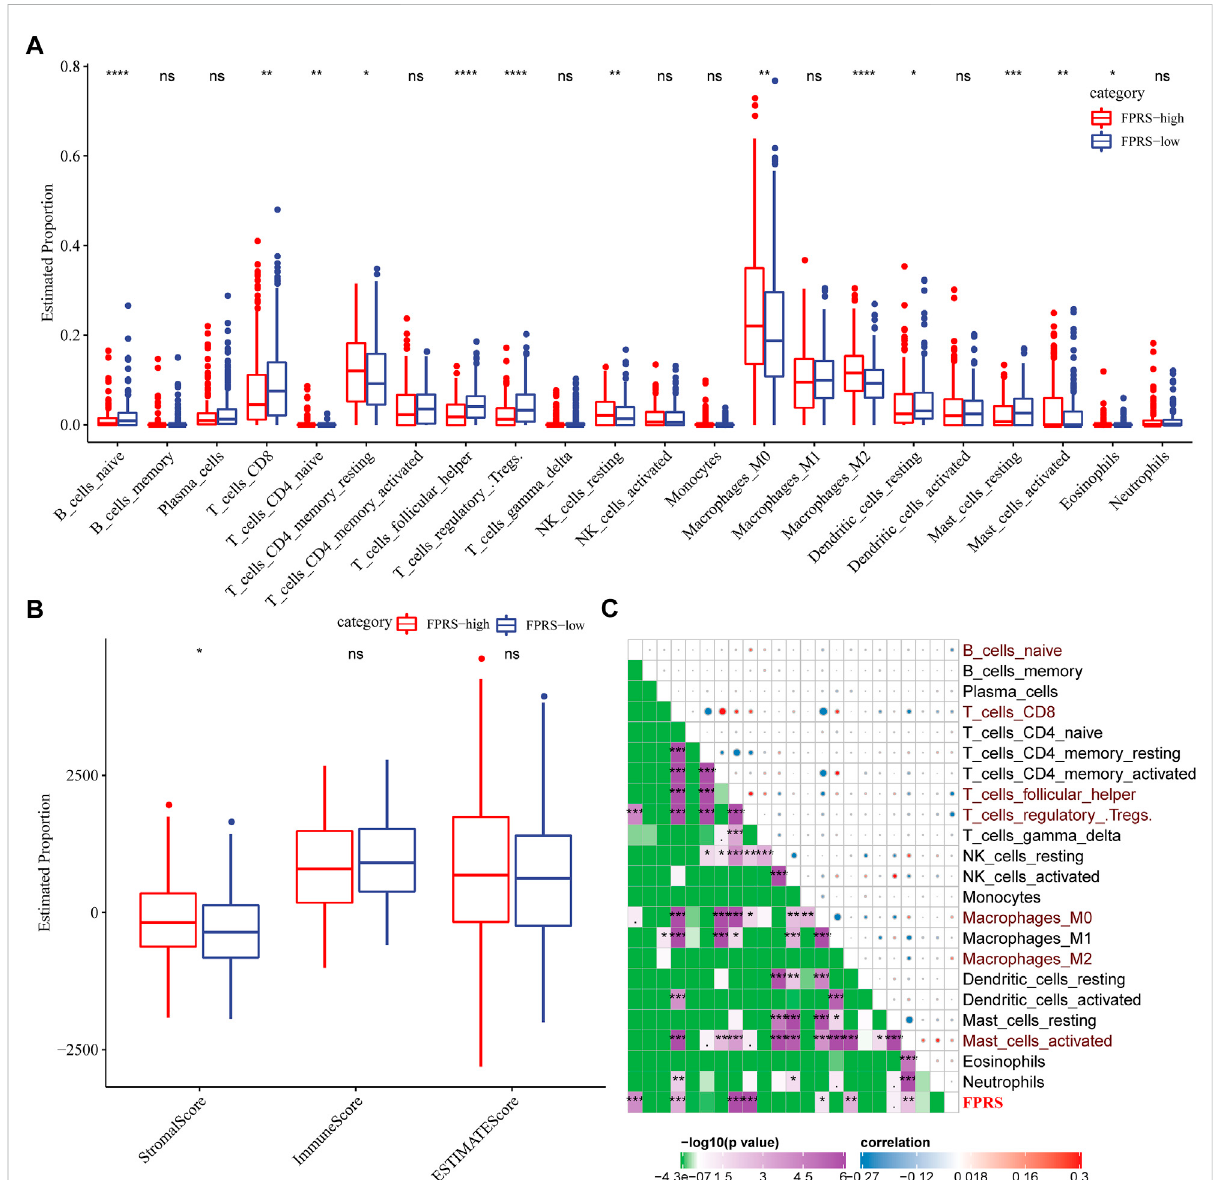
FIGURE 10 Immune signatures between FPRS subgroups. (A) The proportion of immune cell components in the TCGA- HNSC cohort; (B) The proportion of immune cell components in the TCGA-HNSC cohort calculated by ESTIMATE software; (C) The correlation analysis of 22 immune cell components and